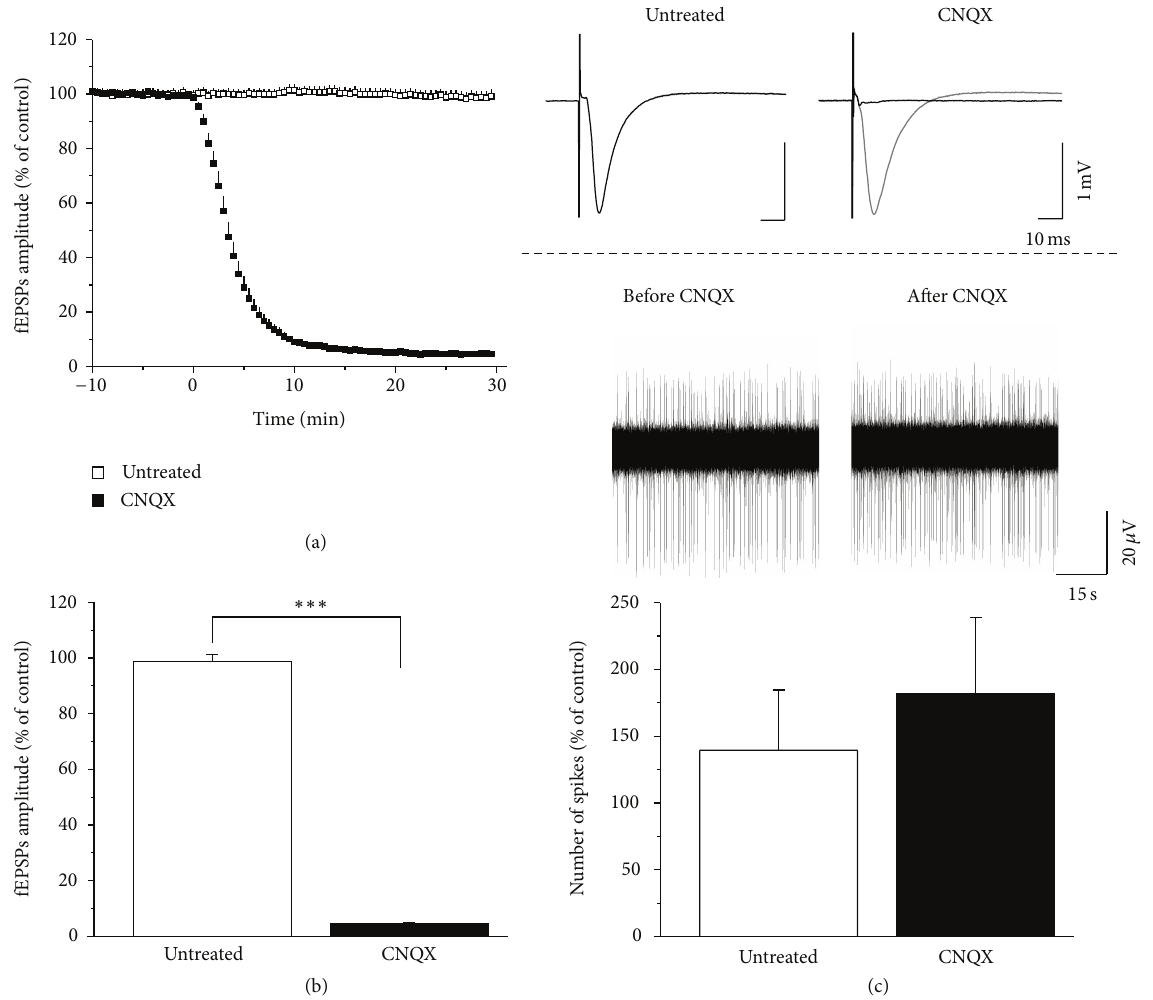
Figure2:AMPAreceptorsmediatefEPSPsbutnotspontaneousactivity.BlockingAMPARsabolishedfEPSPs(a).Bargraphsshowtheaverage of the fEPSPs amplitudes of the 25–30 min period after treatment. CNQX induced a complete reduction of evoked fEPSPs ( 𝑛 = 5 , 𝑃 < 0.001 ) (b); however the spiking activity was not affected (c). Inset at the right panel shows representative fEPSPs before (grey) and after (black) treatment and representative spike trains. Error bars show SEM; ∗∗∗ 𝑃 ≤ 0.001